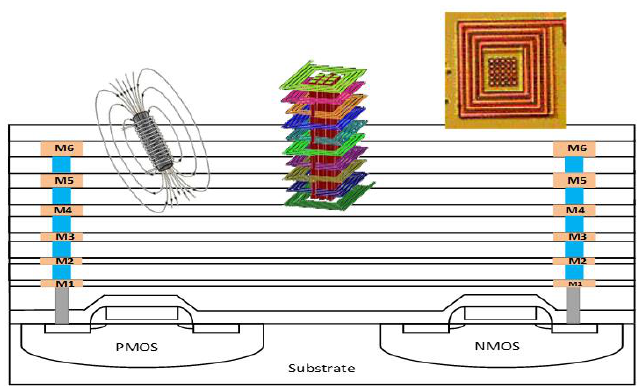
Figure 1. Concept of a stacked-via vertical magnetic-cored inductor in CMOS back end. Insets: a solenoid, simulated multiple-layer spiral inductor with vertical magnetic bar array and a prototype in a CMOS.